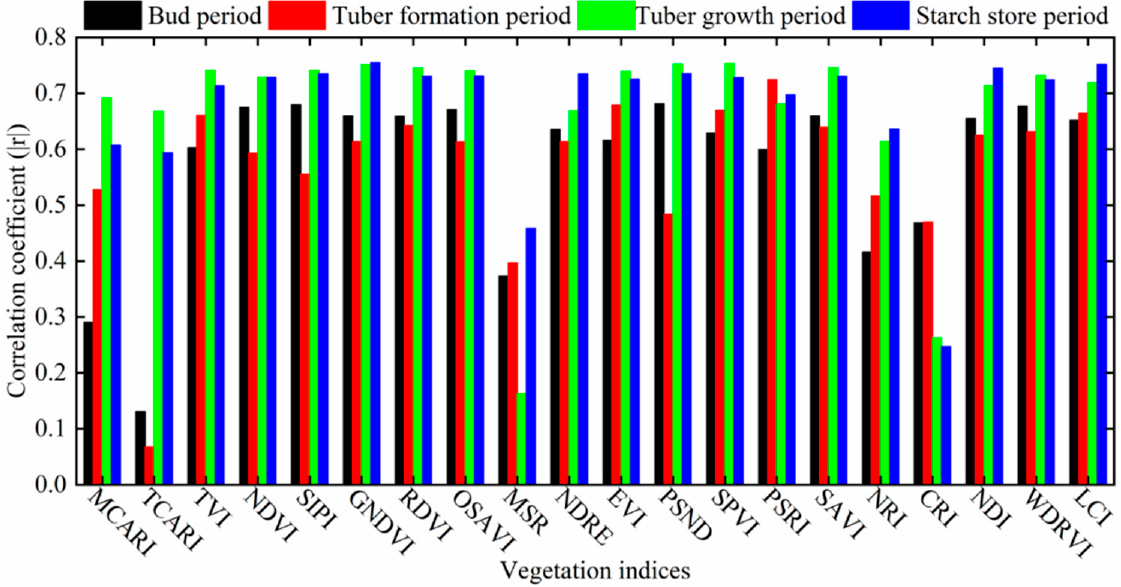
Figure 11. Correlation coefficients of vegetation indexes with measured potato AGB at bud period, tuber-formation period, tuber-growth period, and starch-storage period. Table 4. Vegetation indexes of AGB estimation model were selected by the MWPLS, MC-UVE, and RF methods for each growth